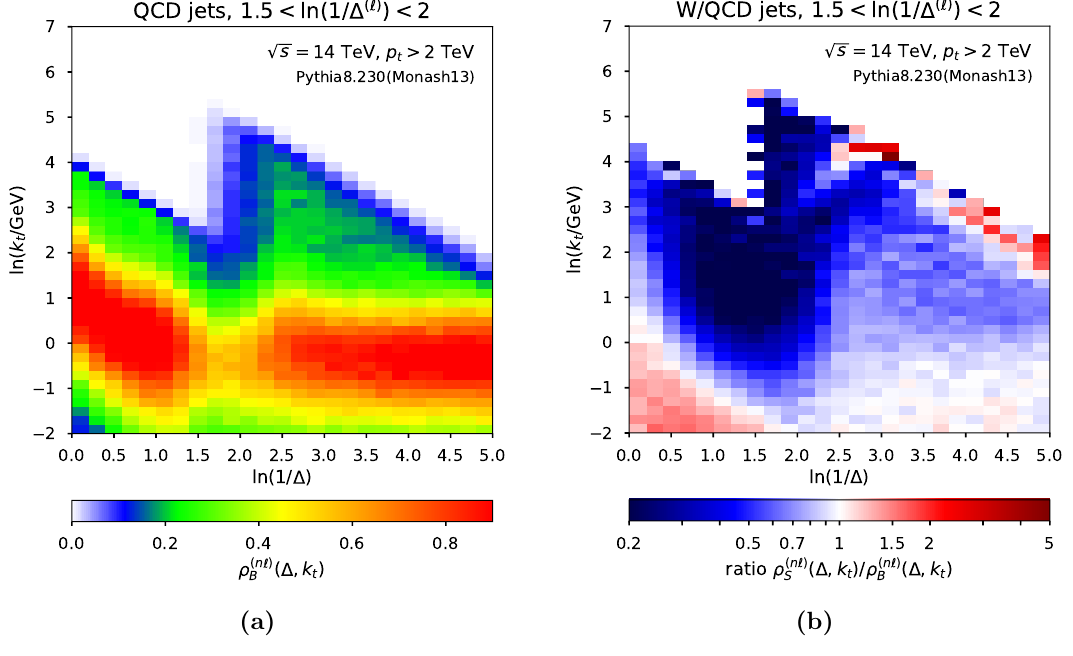
Figure 8. Distribution of the leading emission 1 ( X = B ) and (b) signal W jets ( X = S ). Note the mass peak around ln m ( ‘ ) = ln M W in the case of W jets and the enhancement at larger values of ln z ( ‘ ) .